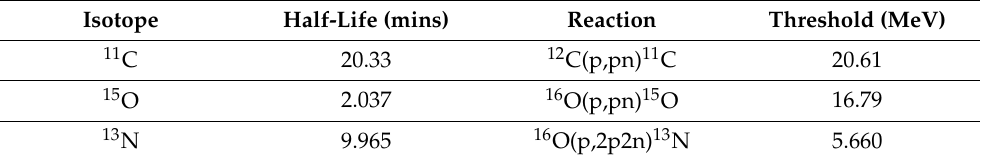
Table 2. List of created isotopes, half-life, reaction and threshold reaction energy.